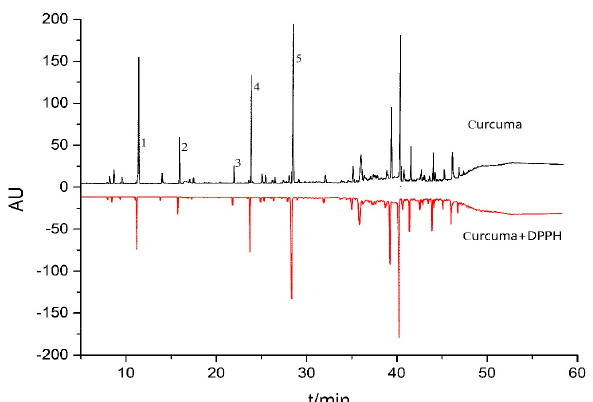
Figure 2. Chromatograms of the Curcuma wenyujin Y.H. Chen et C. Ling essential oil before and after reaction with DPPH radicals. Column: HP-5 phenyl methyl siloxane (30 m × 0.32 mm), column temperature programmed: inlet temperature 65 °C for 2 min, 5 °C / min to 90 °C, 90 °C for 3 min, 8 °C / min to 150 °C, 150 °C for 15 min, 12 °C / min to 180 °C, 180 °C for 3 min, 16 °C / min to 210 °C, 210 °C for 3min, 20 °C / min to 280 °C, 280 °C for 10 min, flow rate 2 mL / min, volume of injection 1 µ L (1.67 mg / mL), spilt mode 50:1, injector temperature 250 °C, carriage gas: N 2 , H 2